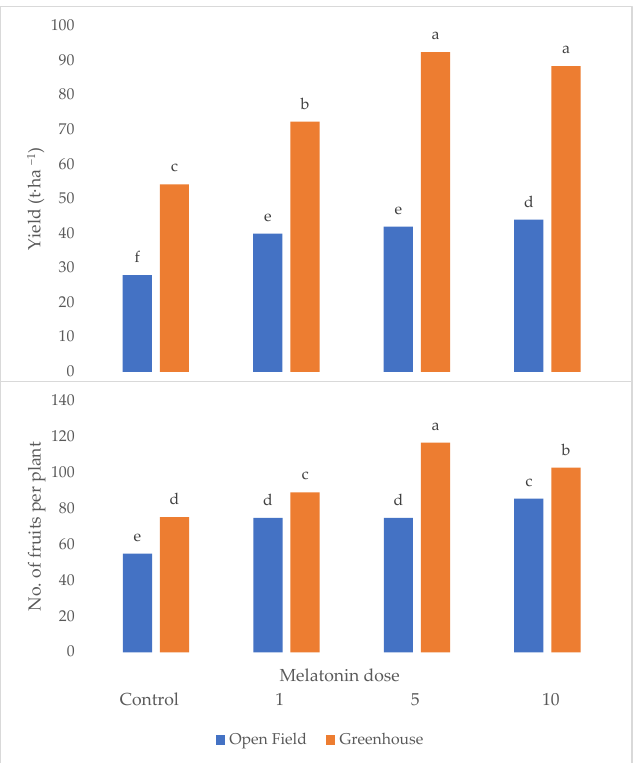
Figure 1. Interaction between crop system and melatonin dose on yield and fruit number per plant of strawberry grown in Isparta region (Turkey); different letters are statistically different according to Tukey’s HSD test at p ≤ 0.05. Table 1. Effects of crop system, cultivar and melatonin concentration on yield and growth parame- ters of strawberry grown in Turkey.